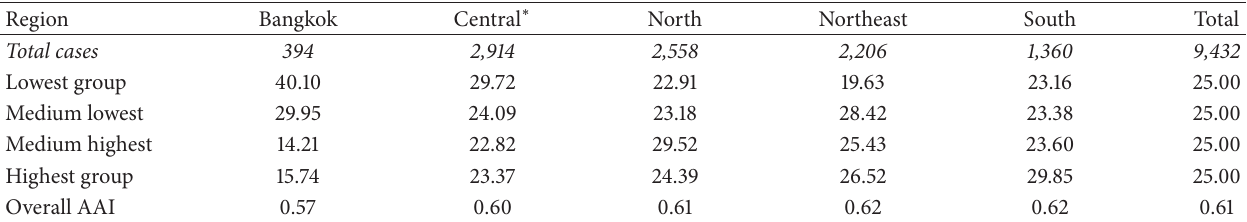
Table 7: Distribution of male older persons according to quartiles of mean active ageing level and region.